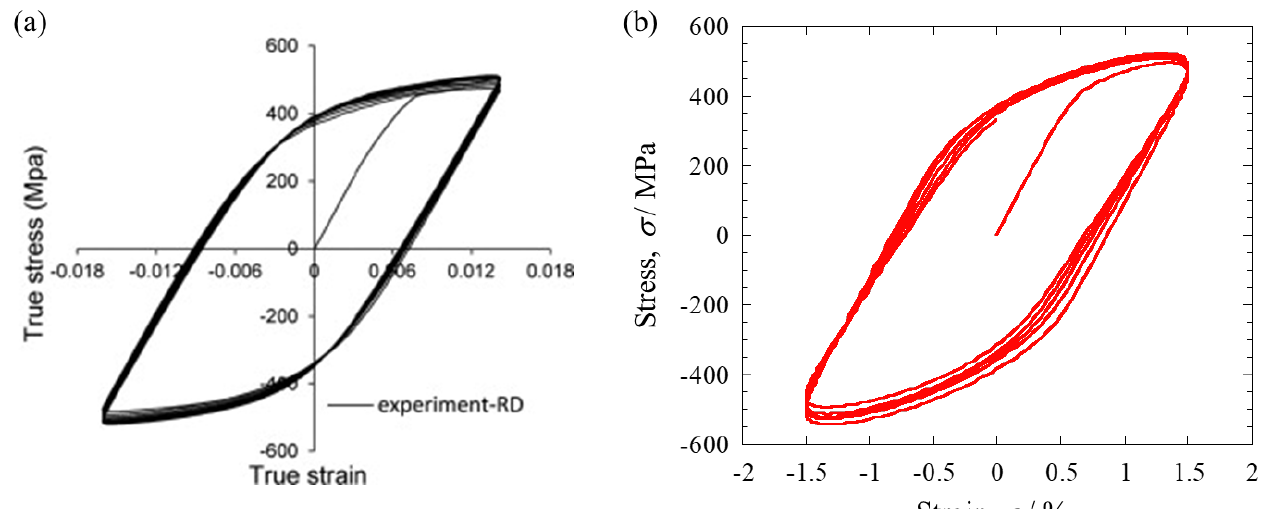
Figure 3. ( a ) First ten hysteresis loops obtained from low-cycle fatigue experiments performed in the rolling direction (reprinted with permission from Ref. [18]), ( b ) calibrated stress-strain hysteresis loops in low-cycle fatigue simulations.